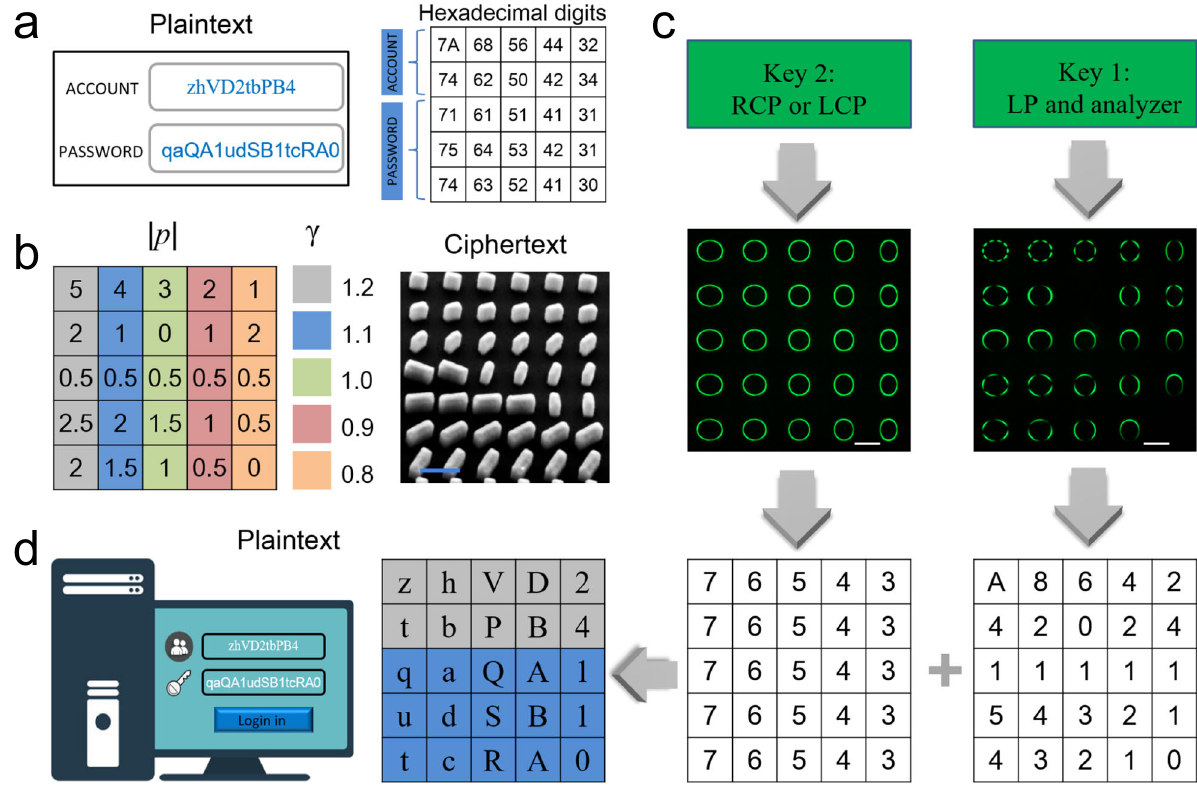
Fig. 5 Proof-of-concept experimental demonstration of optical information encryption. a The plaintext message including a set of complex account number and password composed of different characters (left) are translated into the combinations of hexadecimal numbers (right) by User 1. b The design parameters of the 25 PPBs (left) and SEM image of a portion of the metasurface termed ciphertext (right). Scale bar: 500 nm. c User 2 captures two images with the two customized keys. According to the code chart, the fi rst and second digits of these two-digit hexadecimal numbers are decrypted by User 2, respectively. Scale bar: 50 μ m. d The hexadecimal number combination is decrypted as the plaintext message including the account number and password based on the